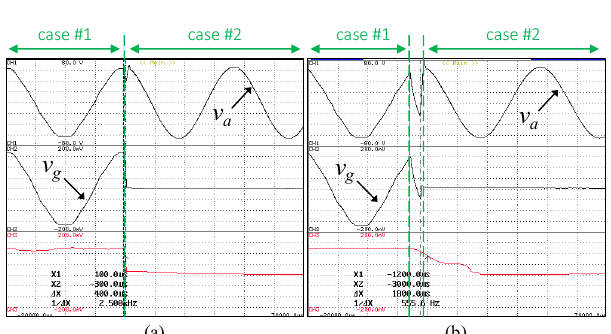
Figure 9. Experimental results: (a) EV battery current ( i bat ) Figure 7. Experimental result showing the detection of a and dc-link voltage ( v dc ) in the G2V mode during the power outage and the beginning of the operation in the V2H transition of the G2V mode to the V2H mode as UPS; mode as UPS based on: (a) Kalman Filter; (b) Traditional (b) Voltage ( v a ) and current ( i a ) in the electrical appliances rms calculation. during the transition from the V2H mode to the normal